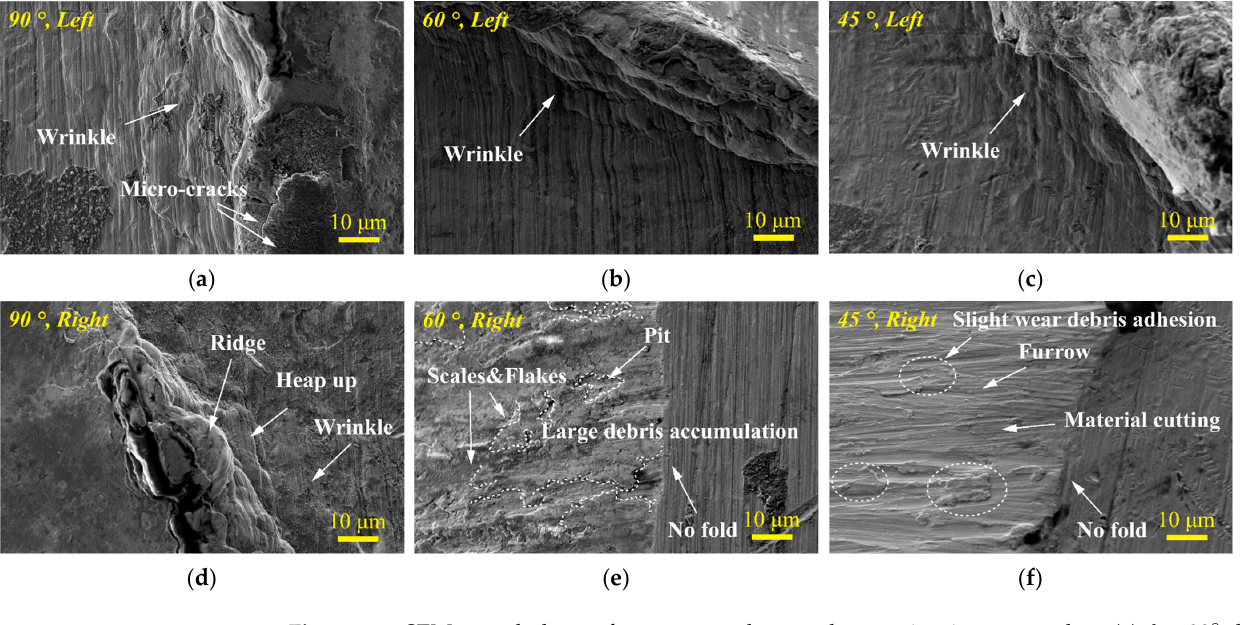
Figure 12. Material accumulation on the left side under different impact angles. ( a ) θ = 90°; ( b ) θ = 60°; ( c ) θ = 45°; and ( d ) wear debris accumulation.